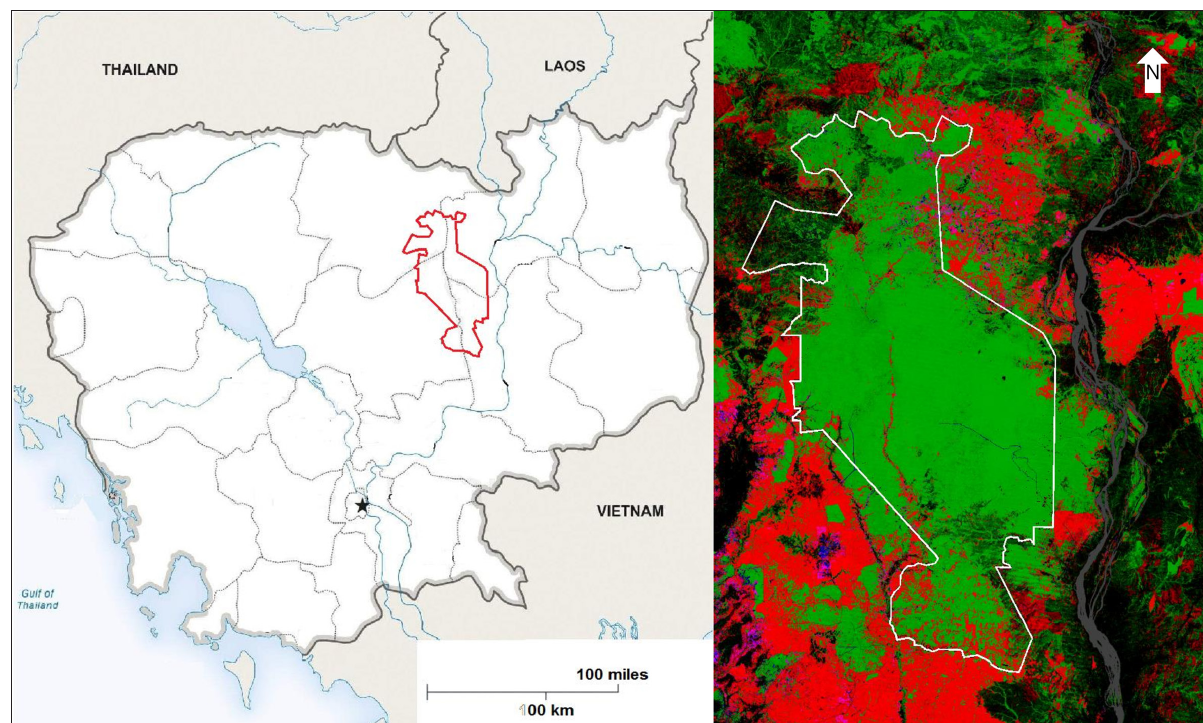
Figure 1: Cambodia’s Prey Lang Wildlife Sanctuary (left) and classified satellite image (right) showing forest loss in years 2000 to 2016 (red), forest cover in 2016 (green), forest gain in years 2000 to 2016 (blue), both gain and loss in years 2000 to 2016 ( purple), and other land uses (black). An asterisk shows the location of the capital city, Phnom Penh. Source: Global Forest Watch – University of Maryland; Hansen et al.